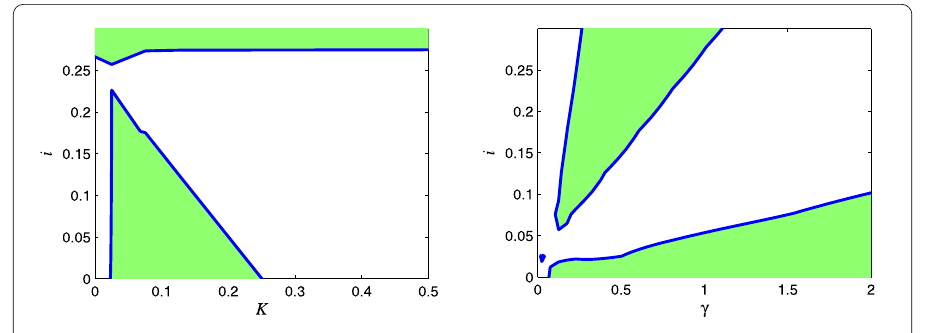
Figure 1 The regions where ( H 1) holds true (color white) in the K – i plane (left) and γ – i plane (right)